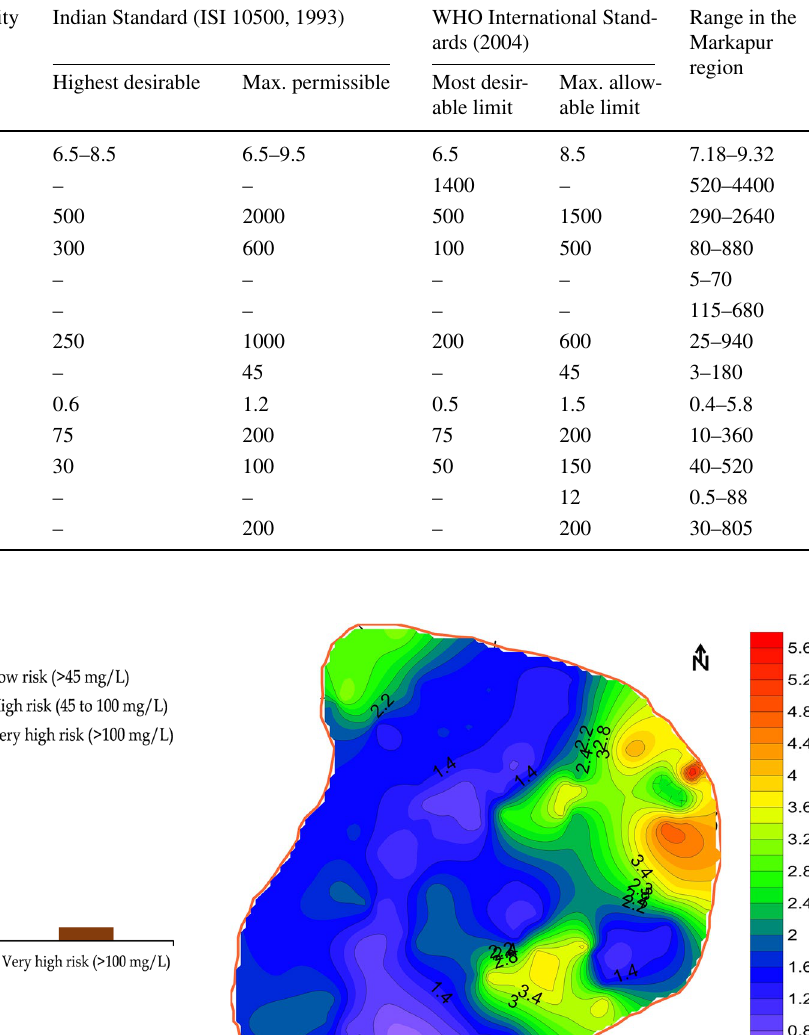
Fig. 2 Distribution of nitrate and its health risk classification in the study area